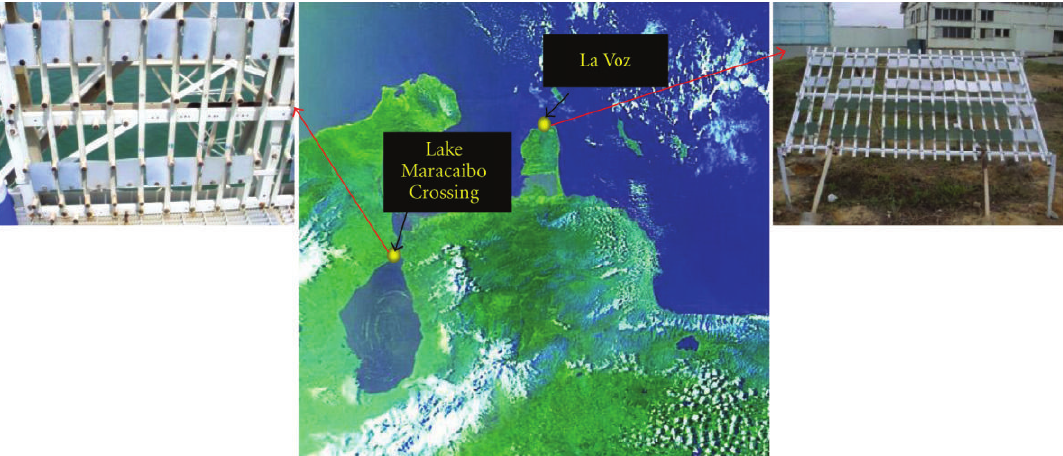
Figure 1: Geographic location of the Lake Maracaibo Crossing Station and La Voz